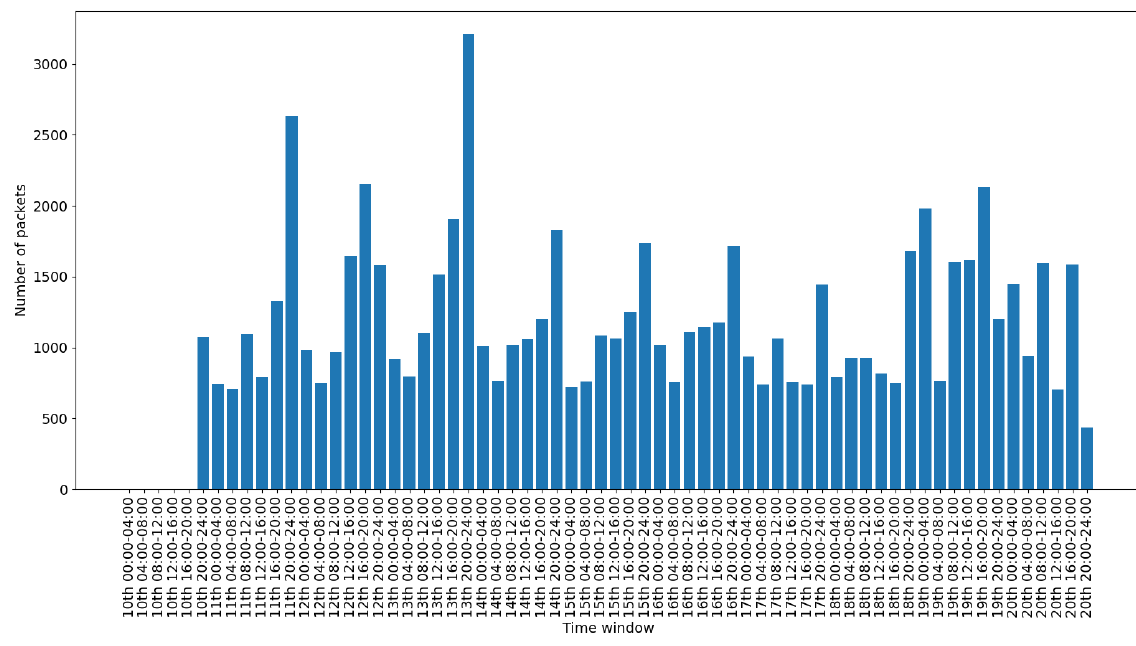
Figure 13. Zigbee packets time